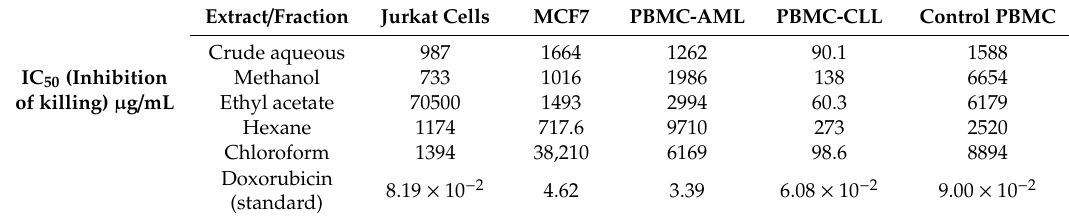
Table 6. IC 50 values exhibited by the crude aqueous extract of N. abor-tristis flowers and its four fractions against the inhibitory activity on primary peripheral blood mononuclear cells (PBMC) from healthy adults (control PBMC), primary peripheral blood mononuclear cells from acute myeloid leukemia patients (PBMC-AML), and primary peripheral blood mononuclear cells from chronic lymphocytic leukemia (PBMC-CLL) patients, the MFC7 breast cancer cell line, and human leukemic T cell lymphoblasts (Jurkat cells).